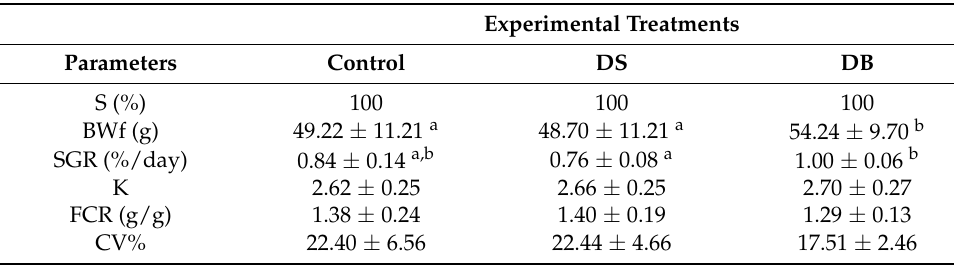
Table 1. Production parameters of European perch ( Perca fluviatilis ) kept in dark-sided (DS) and dark-bottomed (DB) tanks for 8 weeks.